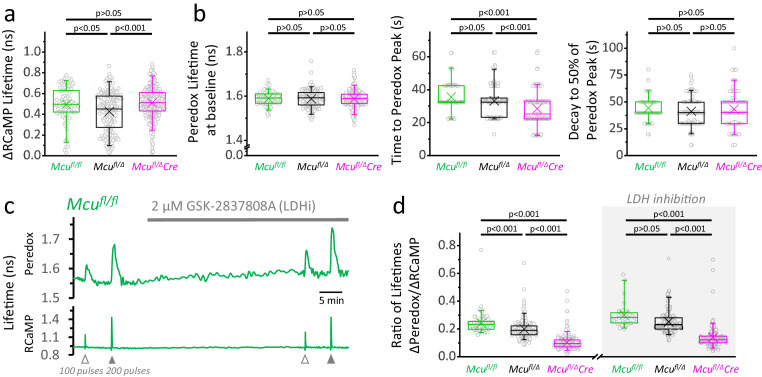
Loss of one Mcu allele slightly reduces the NADHCYT transient.(a) Comparison of the ΔRCaMP lifetime transient among genotypes (sample size for Mcufl/fl mice: Nneurons = 86, Nslices = 9 and Nmice = 4; sample sizes for Mcufl/Δ and Mcufl/ΔDock10Cre mice as in Figure 3d). Only the transients in response to a 200-pulses stimulation were analyzed. (b) Comparison among neurons of different genotypes for parameters derived from the Peredox signal. For the lifetime at baseline, the sample sizes are the same as in the previous section. For the time to peak and the decay to 50% of the peak, only neurons with a ΔPeredox lifetime in response to stimulation of ≥0.05 ns were considered (sample sizes for Mcufl/fl: Nneurons = 79; Mcufl/Δ: Nneurons = 151; Mcufl/ΔDock10Cre: Nneurons = 125). (c) Representative traces of Peredox and RCaMP1h lifetimes simultaneously recorded in a DGC from an adult mouse of Mcufl/fl genotype. In this recording, the LDH inhibitor GSK-2837808A (LDHi) was applied for ~30 min, and the NADHCYT transients were elicited using antidromic stimulation. (d) The lack of MCU causes a gradual decrease in the change of Peredox lifetime relative to the RCaMP spike, indicating smaller NADHCYT transients in response to stimulation (sample size for Mcufl/fl mice: Nneurons = 86, Nslices = 9 and Nmice = 4; sample sizes for Mcufl/Δ and Mcufl/ΔDock10Cre mice as in Figure 3d). Differences between groups could not be rescued by LDH inhibition. The datasets for LDH inhibition correspond to a subset of slices (sample size for Mcufl/fl mice+LDHi: Nneurons = 30, Nslices = 4 and Nmice = 2; sample sizes for Mcufl/Δ and Mcufl/ΔDock10Cre mice as in Figure 3e). The data were compared using a Kruskal-Wallis test with a Dunn post-test.